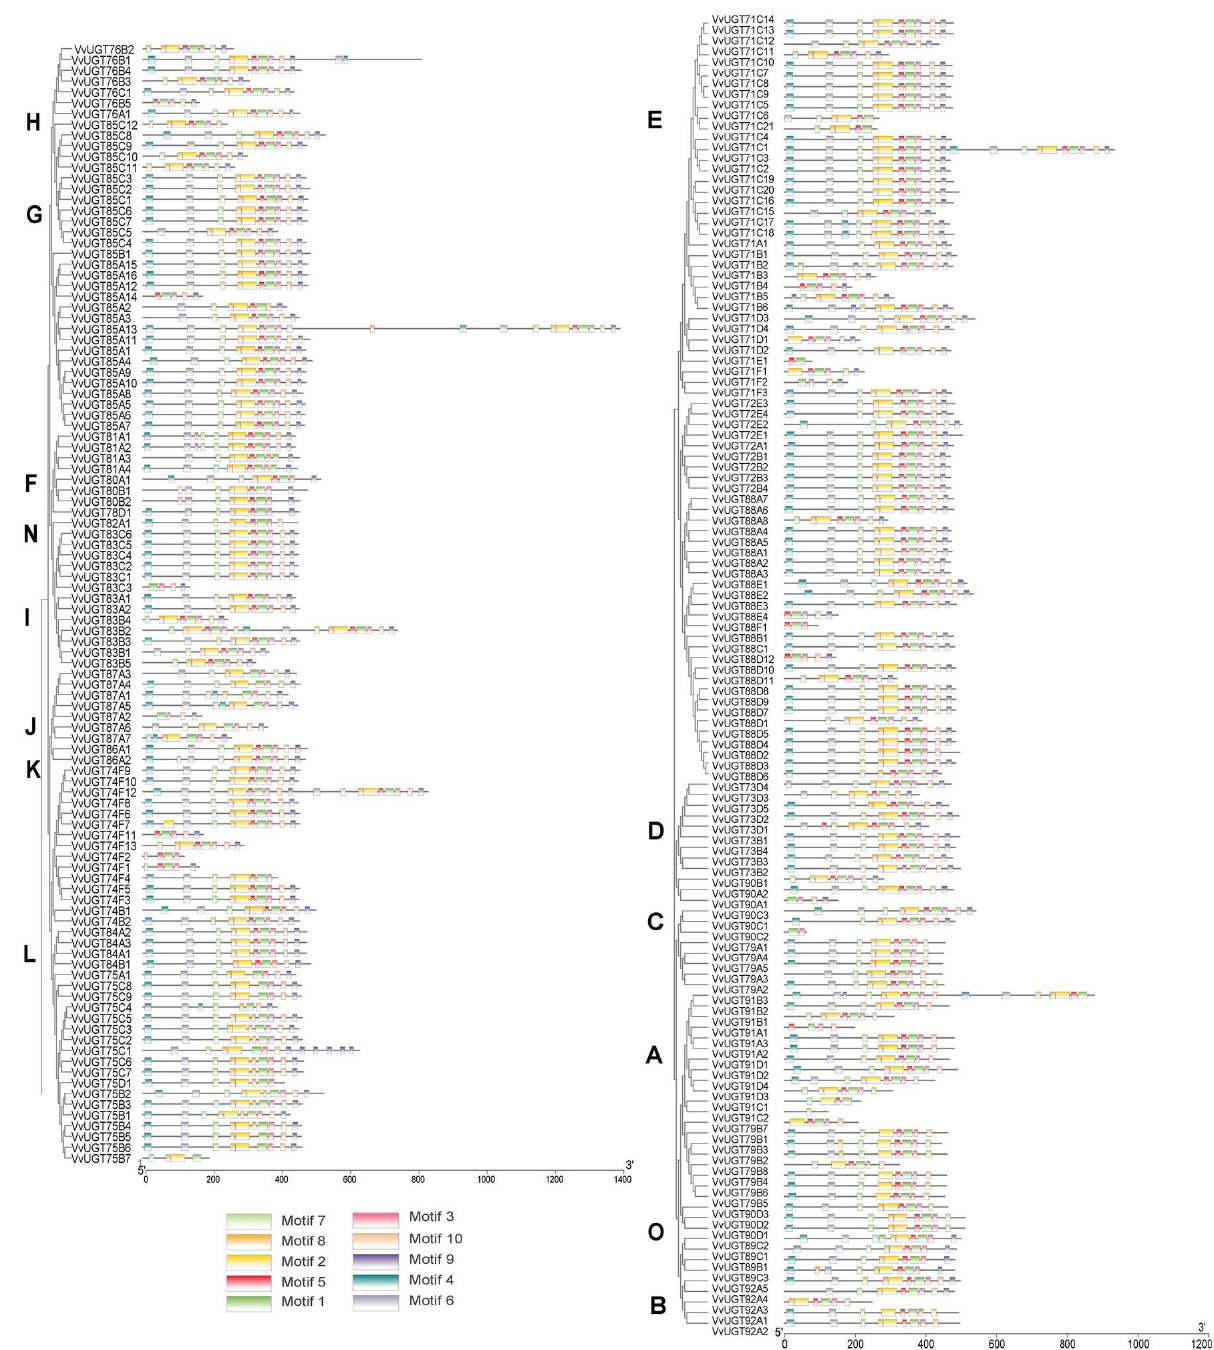
Figure 3. Analysis of conserved motifs of UGT members in